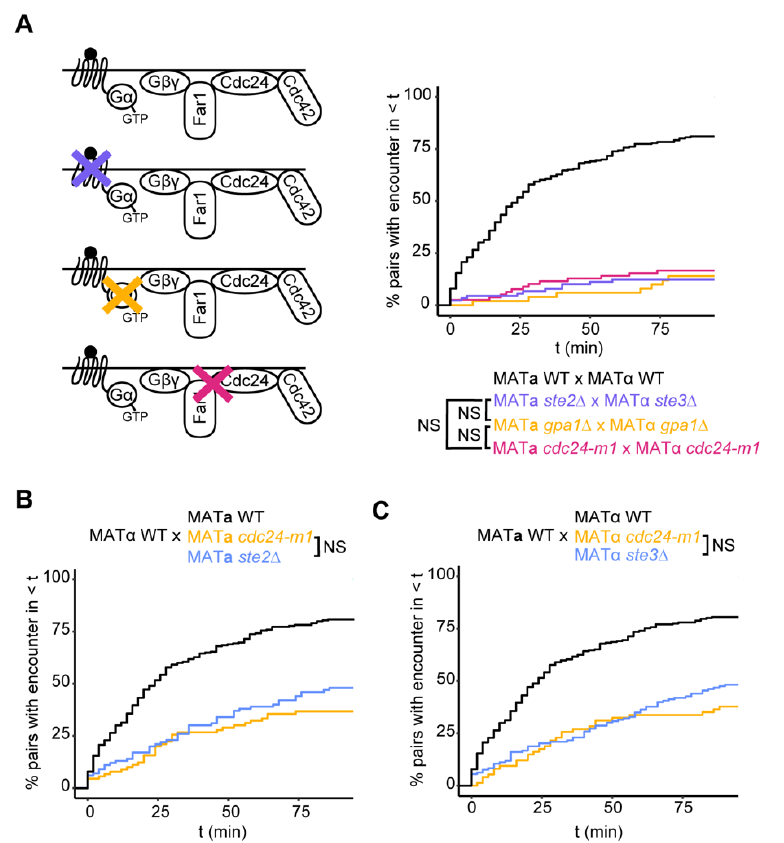
Figure 4. The G protein-Far1-Cdc24 pathway is required for gradient decoding. ( A ) Left: Sig- naling from active pheromone receptor to Cdc42, with genetic disruptions in the pathway in- dicated: purple ‘X’ = ste2 ∆ or ste3 ∆ , yellow ‘X’ = gpa1 ∆ , magenta ‘X’ = cdc24-m1 . Right: Cu- mulative distributions of the time to polarity site encounter in mating mixes where both part- ners lack pheromone receptors, G α or an intact Far1 pathway ( cdc24-m1 ): MAT a ste2 ∆ × MAT α ste3 ∆ (DLY23978 × DLY23979), MAT a gpa1 ∆ × MAT α gpa1 ∆ (DLY24101 × DLY24104), MAT a cdc24-m1 × MAT α cdc24-m1 (DLY22532 × DLY22533) ( n ≥ 50 pairs) (NS = KS test p > 0.05). ( B , C ) Cumulative distributions of the time to polarity site encounter in mating mixes where only the MAT α ( B ) or MAT a ( C ) has an intact Far1 pathway (strains for cdc24-m1 unilateral mixes: DLY2067 × DLY22532 or DLY20626 × 22533, strains for receptorless unilateral mixes same as in Figure 3) ( n ≥ 74 pairs) (NS = KS test p >